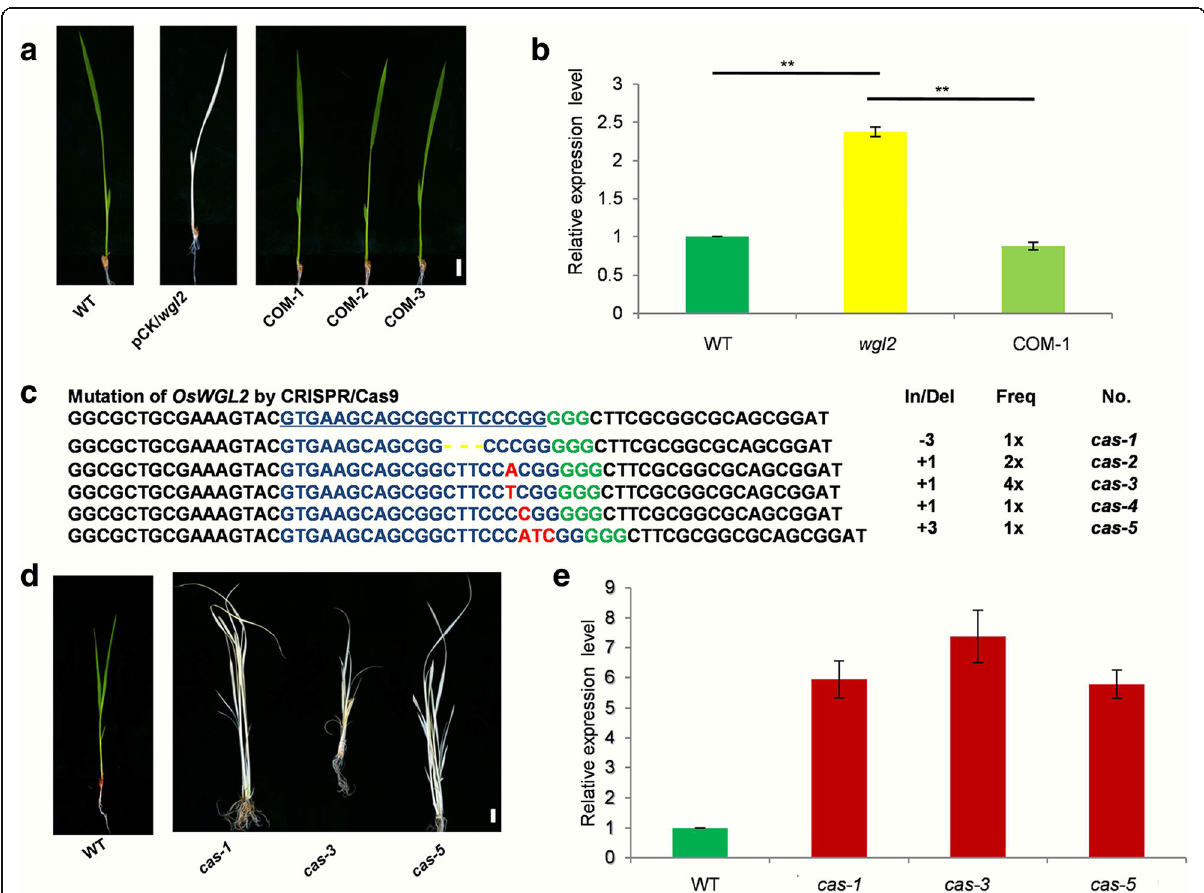
Fig. 4 Complementation and targeted deletion experiments. a From left to right: wild type (WT), wgl2 with pCAMBIA1300 (pCK/ wgl2 ), and seedlings from three independent WGL2 complementation lines (COM-1, 2, and 3) (bar=1 cm). b Relative WGL2 transcript levels in WT, wgl2 , and complementation transgenic plants. c Sequence confirmation of the WGL2 deletion in WT plants harboring Cas9/sgRNA constructs. The 20-nt target sequence of the Cas9/ sgRNA complex is underlined in blue, and the PAM site is indicated in green. For the Cas9/sgRNA-mutated DNA sequences, inserted nucleotides are shown in red, and deleted nucleotides are depicted as yellow dots. d Phenotypes of mutant seedlings harboring the WLG2 Cas9/sgRNA constructs (bar=1 cm). e Relative transcript levels of WGL2 in WT and three independent mutant transgenic plants. The WGL2 transcript levels in WT were set to 1. Values represent the mean±SD of 3 biological